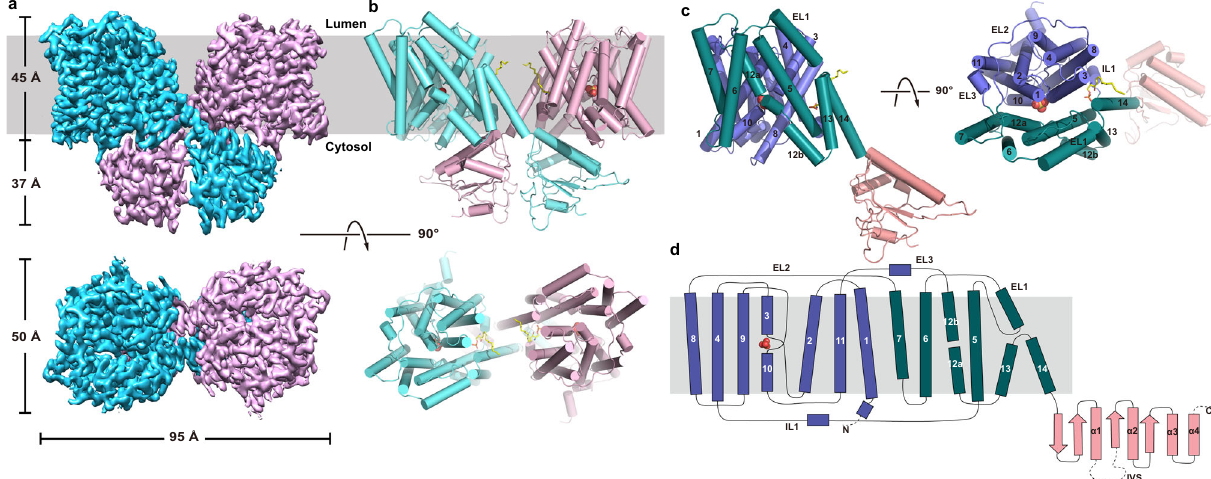
Fig. 2 Structure of AtSULTR4;1. a , b Electron density map (left) and cartoon representation (right) of the AtSULTR4;1 dimer as viewed from within the plane of the membrane (upper row), or the luminal side of the membrane (bottom row). Helices in the cartoon representation are shown as cylinders. c Cartoon representation of AtSULTR4;1 monomer in two orientations. The core domain, gate domain, and STAS domain are colored violet, teal, and pink, respectively. The bound SO 4 2 − is shown as spheres. d Topology of AtSULTR4;1.